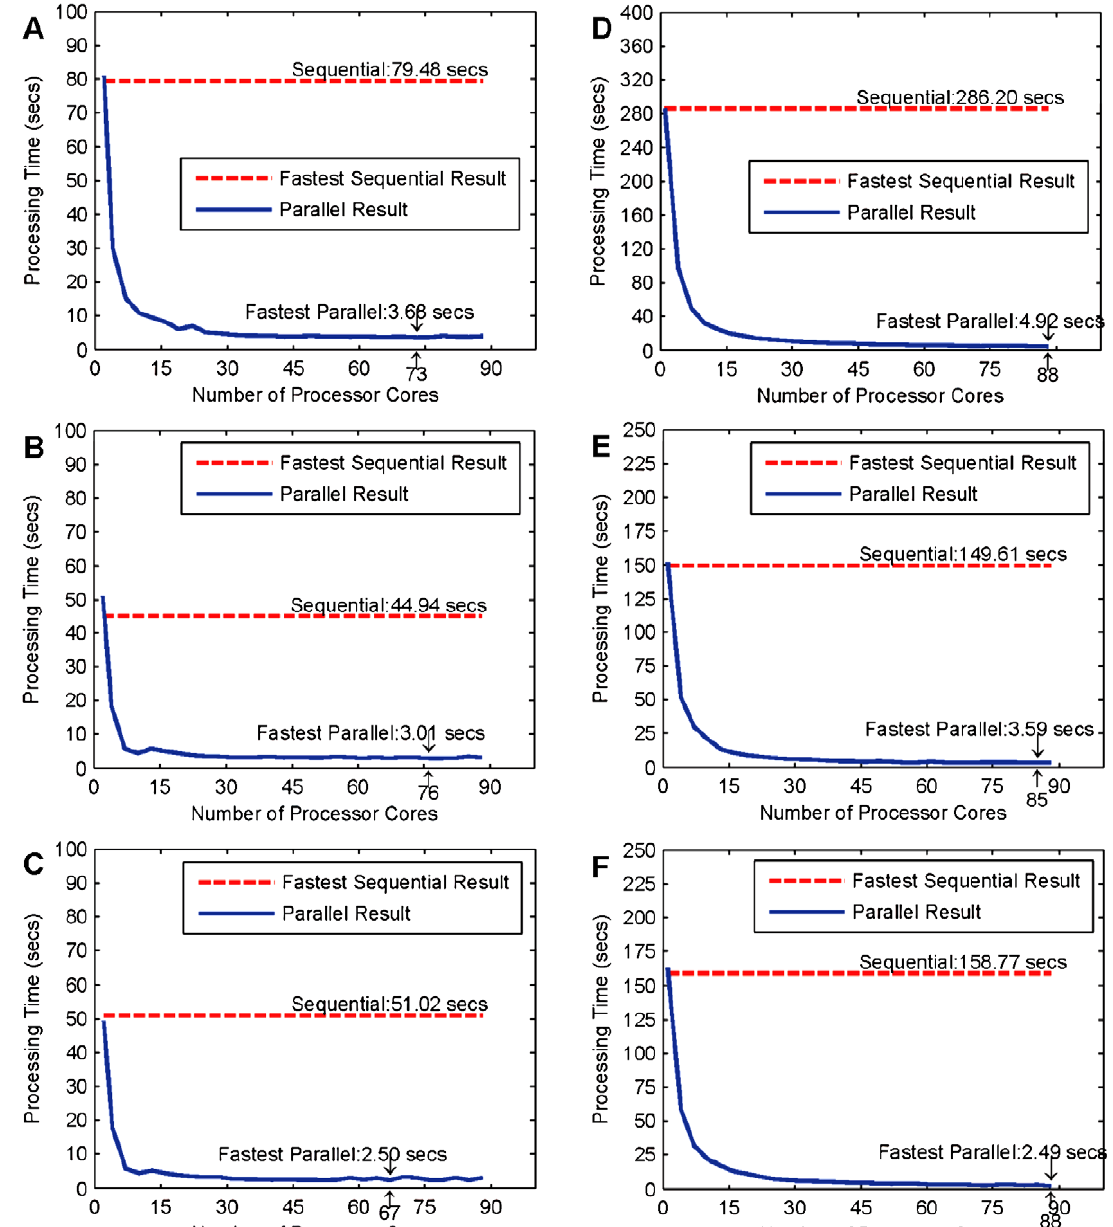
Fig. 4. Results for the time in seconds taken to load (A–C) and save (D–F) virtual slides. Time is plotted against the number of processor cores used. The dashed line shows the corresponding time taken using the fastest sequential code. Loading times for (A) TMA1, (B) TMA2 and (C) TMA 3 are plotted together with saving time for (D) TMA1, (E) TMA2 and (F) TMA 3. It is evident that increasing the number processing cores significantly speeds up both loading and saving of digital images. (Colours are visible in the online version of the article; http://dx.doi.org/